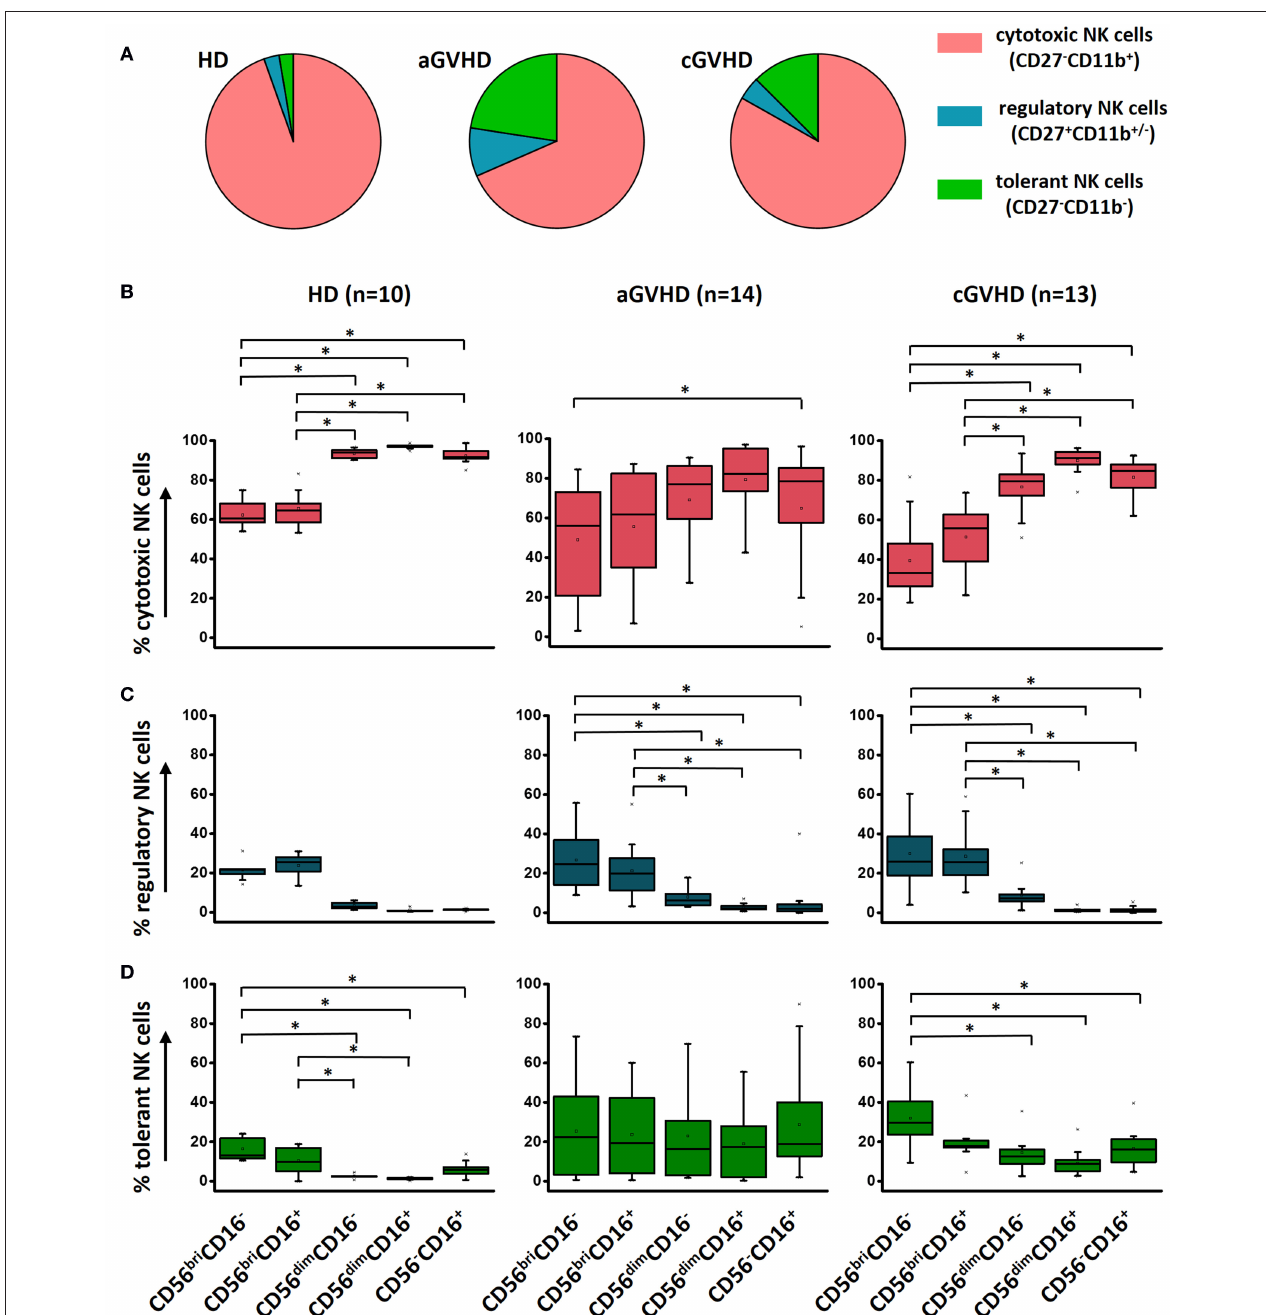
FIGURE 4 | Characterization of functional NK subsets. Based on the expression of CD11b and CD27, NK cells could be defined as three functional subsets: CD11b + CD27 − cytotoxic NK cells, CD11b + / − CD27 + regulatory NK cells and CD11b − CD27 − tolerant NK cells. Although the frequency of these three subsets is different among HDs ( n = 10), aGVHD ( n = 14, excluding patient #5 and #8 due to the limited cell number of samples) and cGVHD ( n = 13, excluding patient #17, #18, #21, #22, and #25 due to the limited cell number of samples) groups (A) , the component of cytotoxic (B) , and regulatory (C) NK cells is similar in five subpopulations among three different groups except the tolerant NK cells (D) . * p <